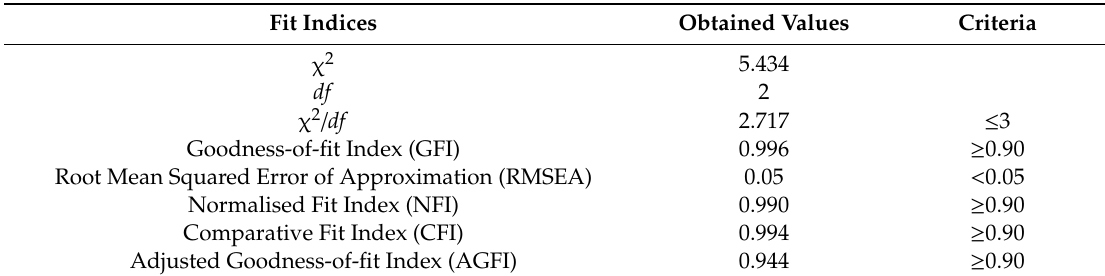
Table 3. Goodness of fit measure.